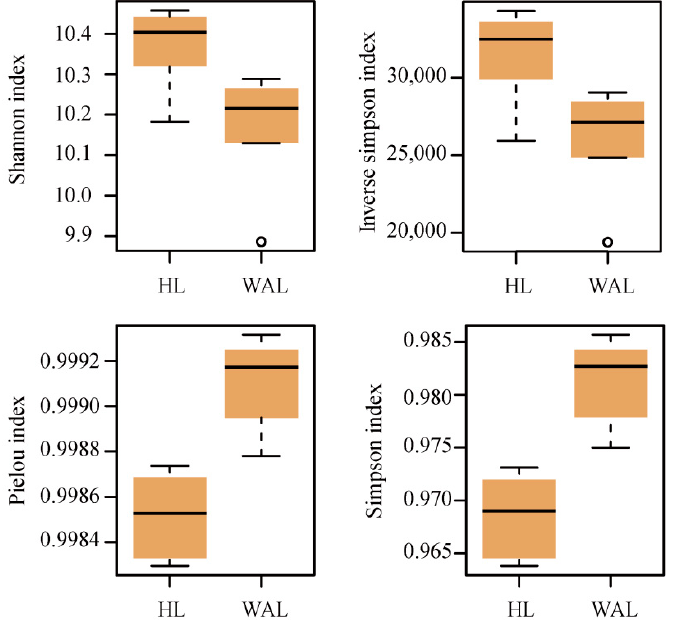
Figure 2. The alpha diversity of microbial functional genes in the HL and the RAL. Four alpha diversity indexes were used, including the diversity indexes (the Shannon-Weaver index and the inverse of Simpson) and the evenness indexes (the Pielou’s evenness and the Simpson’s evenness).